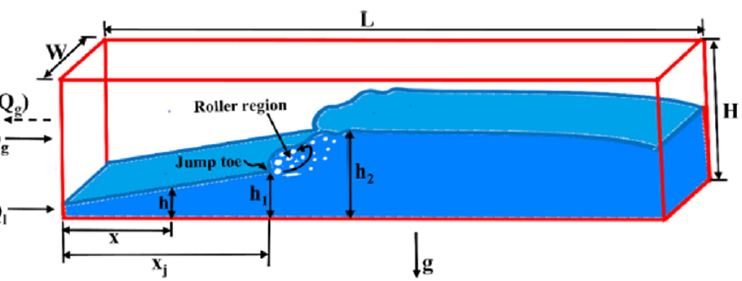
Figure 5. Schematic of internal hydraulic jump in a narrow rectangular channel (Dhar et al. [43]).